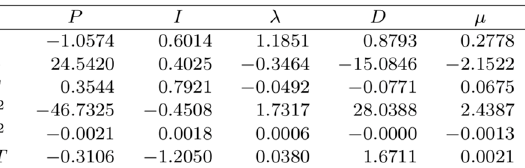
Figure 4. Parameters for the first set of tuning rules for S-shaped response processes ( P = k p , I = k p / T i , D = k p T d ) [32].